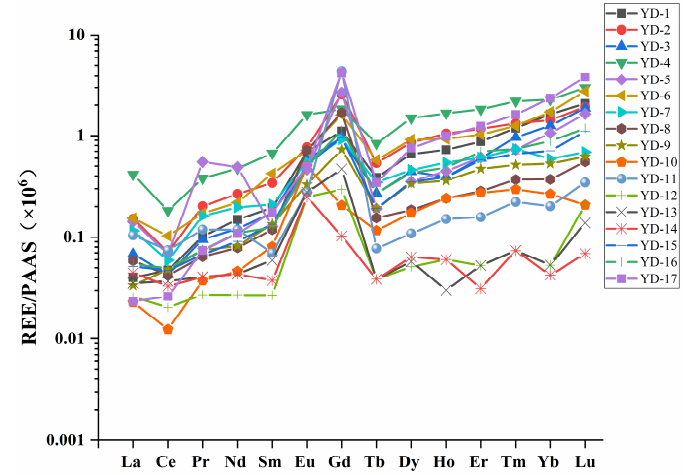
Figure 3. PAAS ‐ normalized REE distribution pattern.